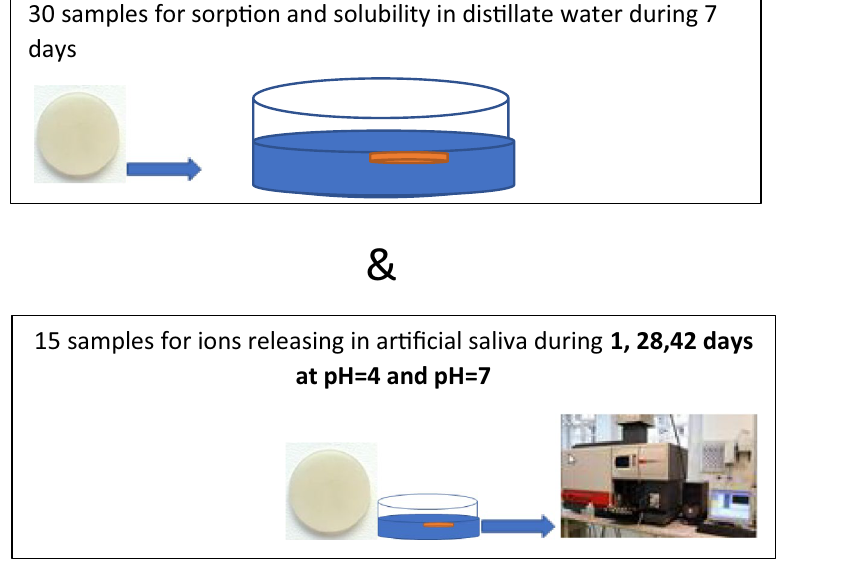
Figure 1. Scheme of sample preparation and